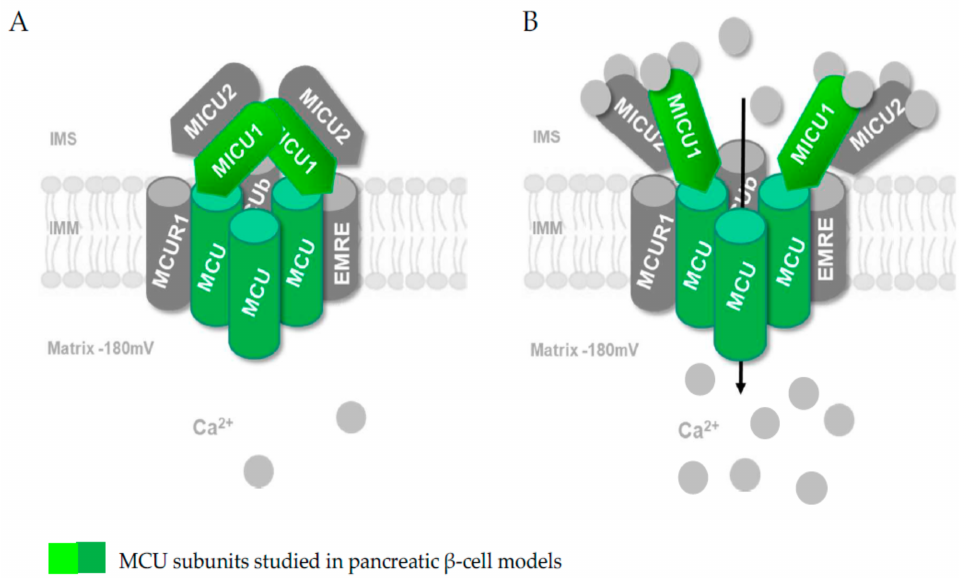
Figure 2. The mitochondrial calcium uniporter (MCU) comprises distinct pore-forming (MCU/MCUb) and associated proteins (essential MCU regulator (EMRE), mitochondrial calcium uptake (MICU) 1, MICU2, MICU3 and mitochondrial calcium uniporter regulator 1 (MCUR1)). The subunits that have already been studied in models of the pancreatic β -cell are rendered in green. ( A ) Model of the closed conformation of MCU. ( B ) Following glucose stimulation, the entry of Ca 2+ into the matrix space is mediated by MCU. IMM, inner mitochondrial membrane; IMS, intermembrane